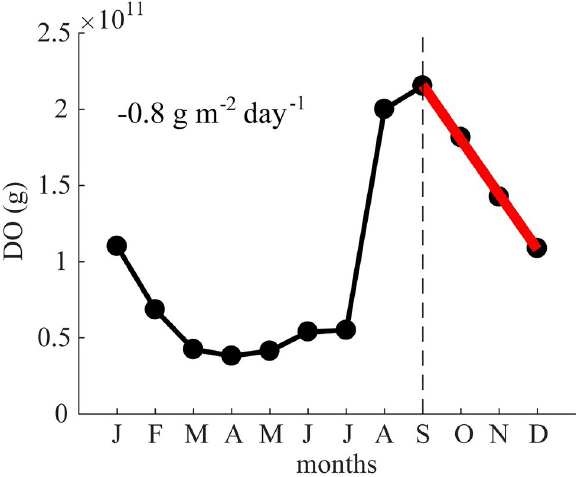
Fig 9. Hypolimnetic mass of dissolved oxygen in Lake Kariba. Mean year of dissolved oxygen mass in the hypolimnion of Lake Kariba. The mean year is based on the aggregated database of this study. The hypolimnion concentration was calculated as the mean of the deepest five meters. The red line represents the regression line used to calculate the areal hypolimnetic oxygen depletion rate (AHOD).